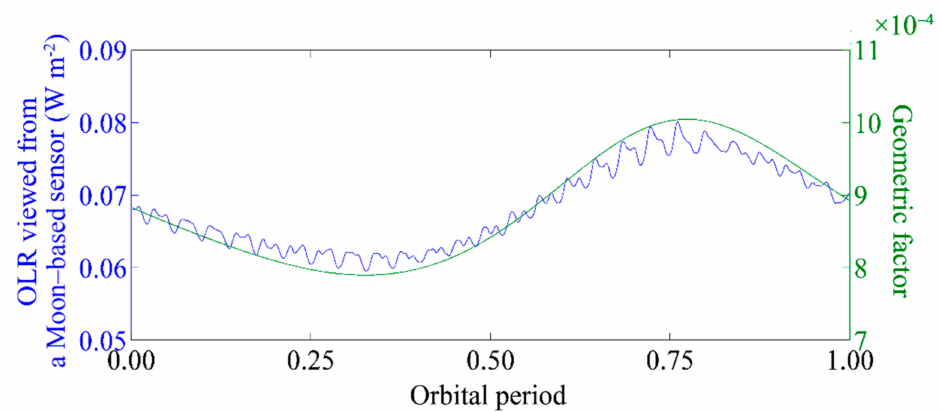
Figure 9. Comparisons of Moon-based outgoing long-wave radiation (OLR) measurements (blue curve) and the integrated geometric factor (green curve) during one orbital period.